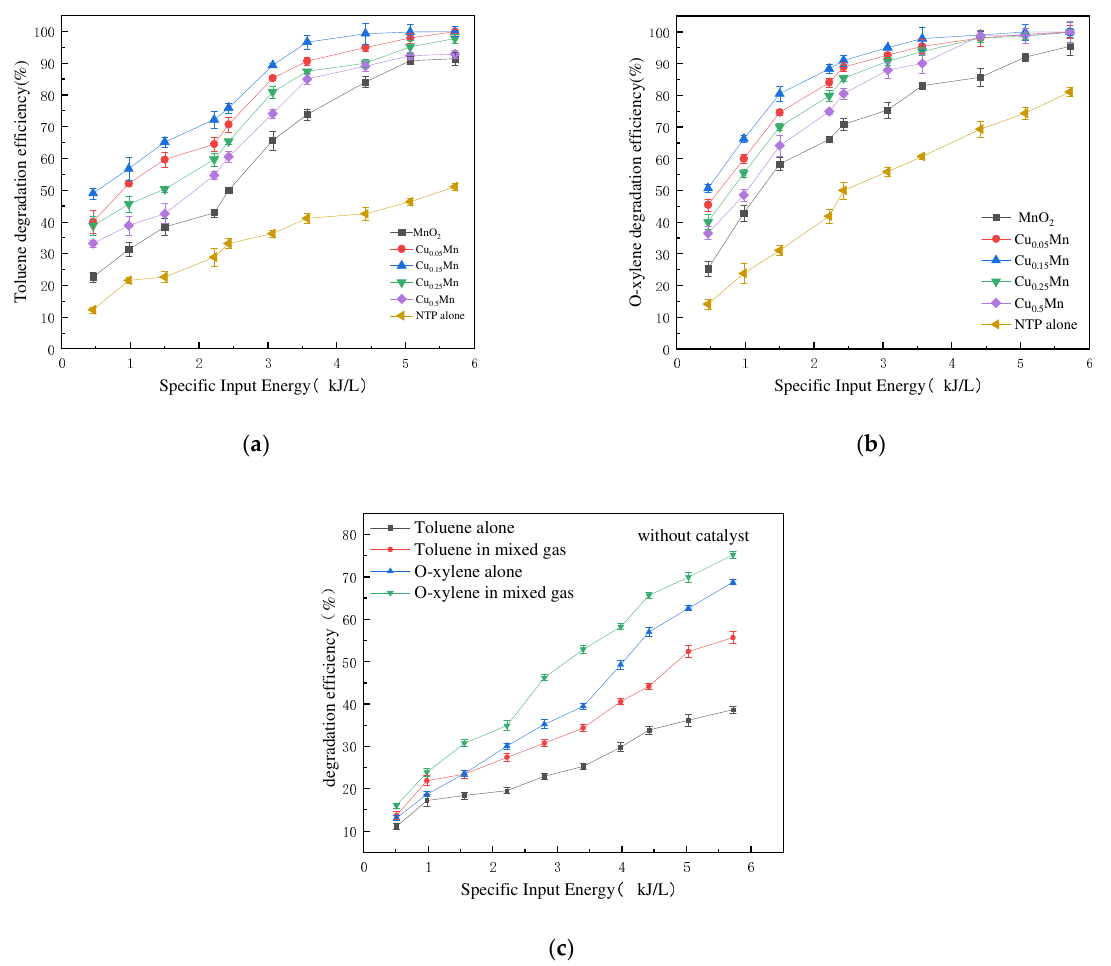
Figure 5. Degradation efficiency of toluene and o-xylene with different catalysts and mixed gas without catalyst. ( a ) Toluene, ( b ) o-xylene, ( c ) mixed gas without catalyst.